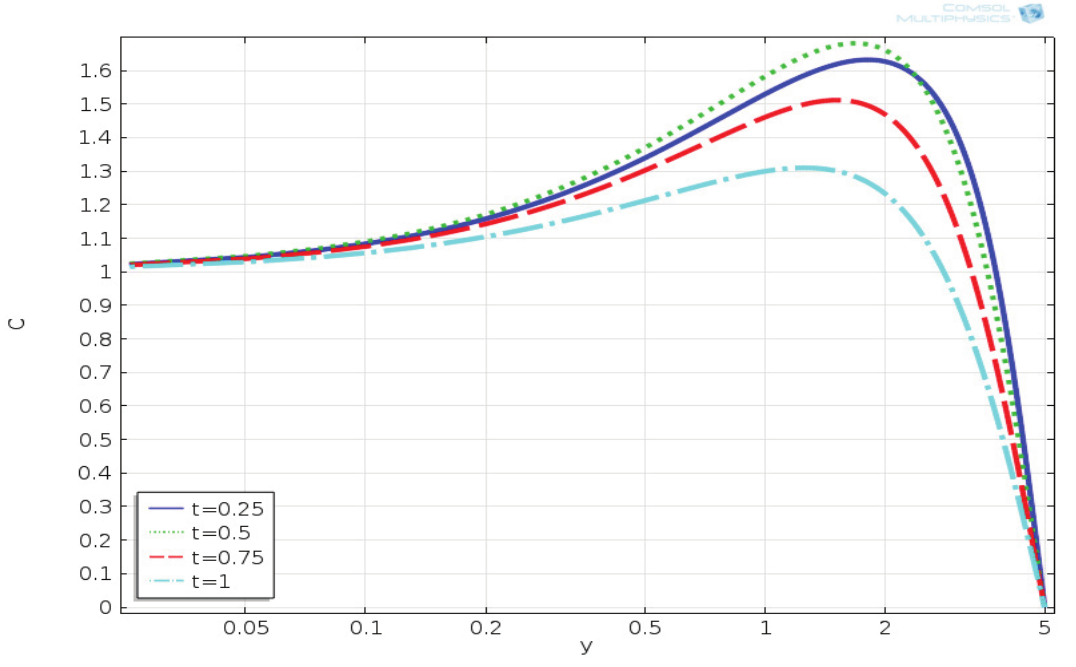
Figure 4: Concentration profiles for different times at